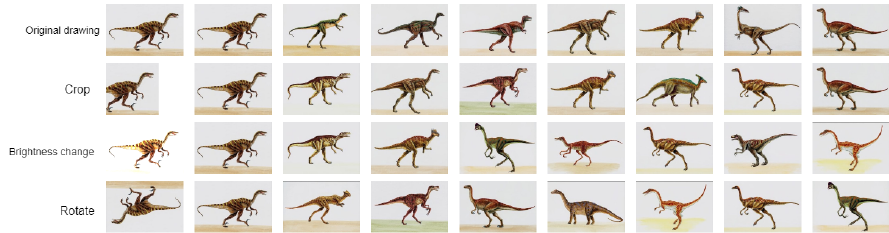
Figure 10. For example, the top 8 return results of image retrieval under different